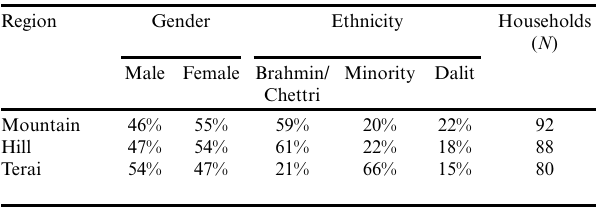
Fig. 4. Percentage of respondents surveyed in each of three regions across the Karnali basin who use river water for common activities. N =